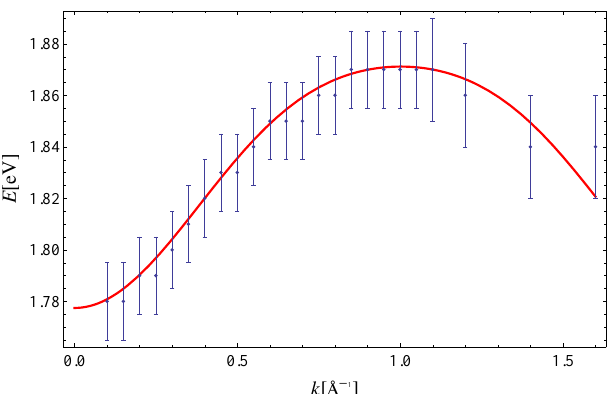
Figure 2. Exciton dispersion along the ( 100 ) direction. Experimental data are taken from Reference [3]. The theoretical curve is obtained for: ∆ = 1.83 eV [33], I x